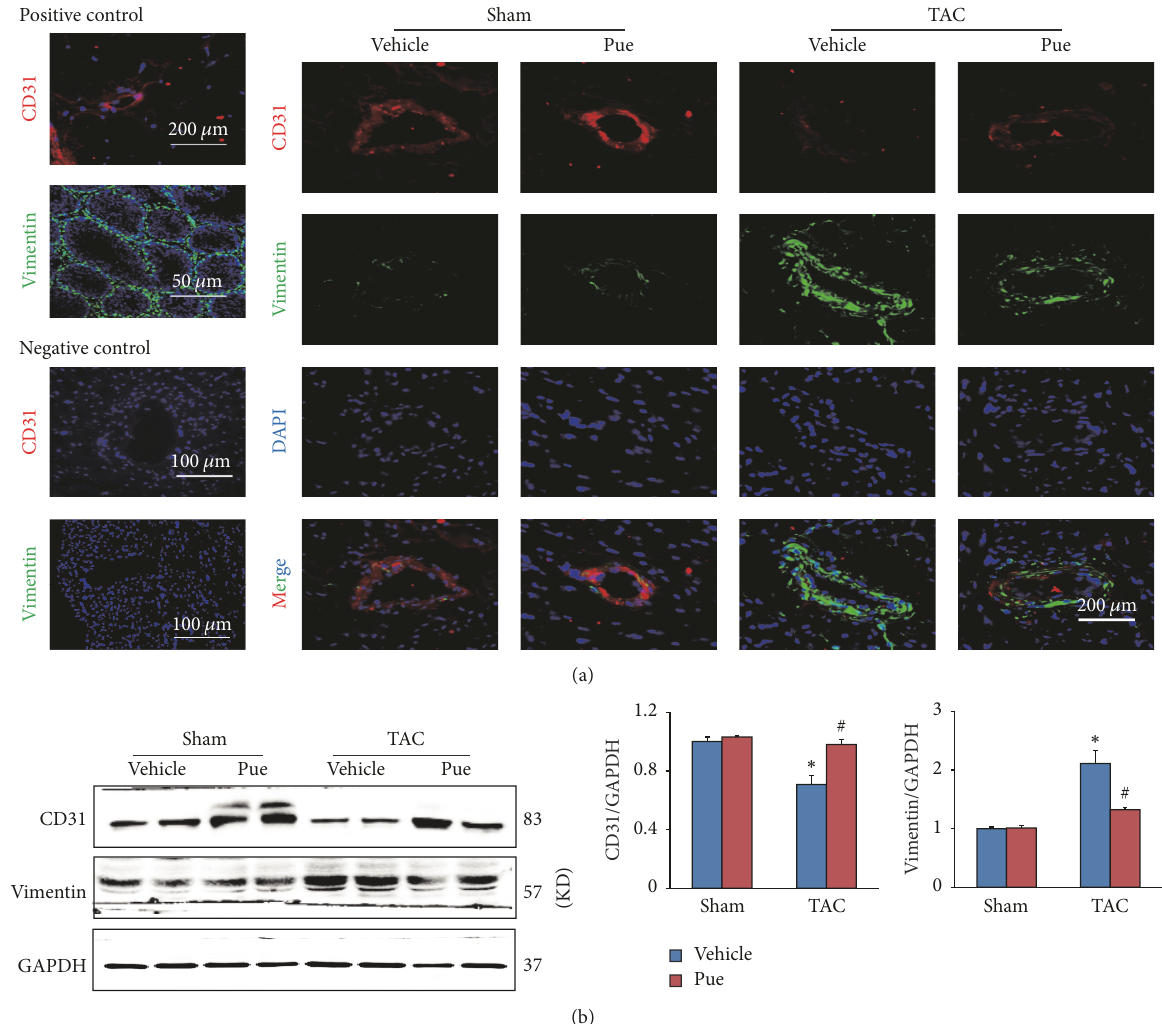
Figure 2: Puerarin protected against cardiac fibrosis by inhibiting EndMT . (a) Immunofluorescence colocalization of CD31 (red) and vimentin (green) was tested on frozen sections of mice hearts in indicated groups (scale bars: 200 𝜇 m). The left panel was positive and negative controls. Positive control: CD31 (red) counterstained with DAPI (blue) in the muscle of mouse; vimentin (green) counterstained with DAPI (blue) in the testis of mouse. Negative control: heart tissue incubated with PBS instead of primary antibodies against CD31 or vimentin. (b) Protein expressions of CD31 and vimentin were determined by WB, normalized to GAPDH (𝑛 = 6) . ∗ 𝑝 < 0.05 versus sham + vehicle group; # 𝑝 < 0.05 versus TAC + vehicle